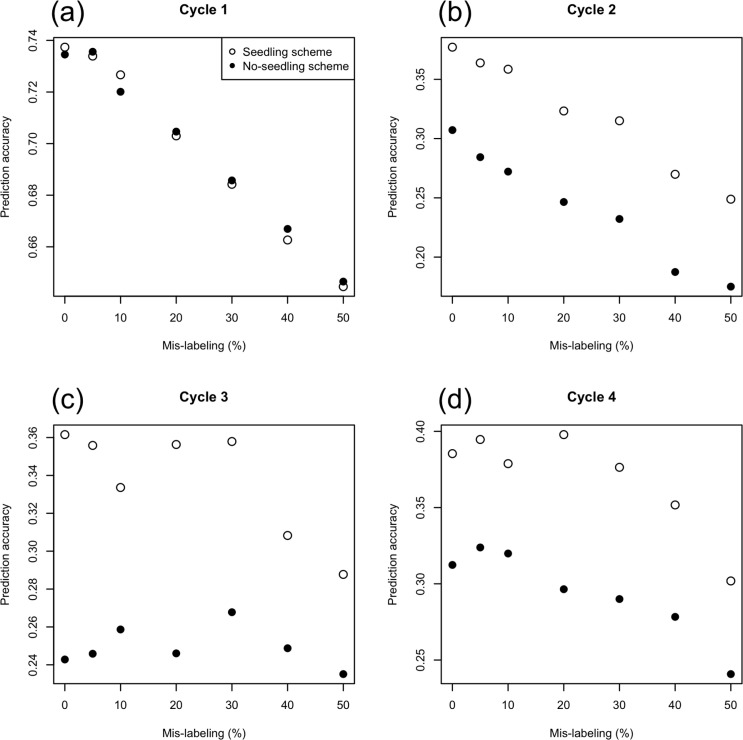
Relationship between prediction accuracy and mislabeling from Cycle 1 to Cycle 4 with source errors at (a) Cycle 1, (b) Cycle 2, (c) Cycle 3, and (d) Cycle 4. Note that the scale of the y axis changes among figures.